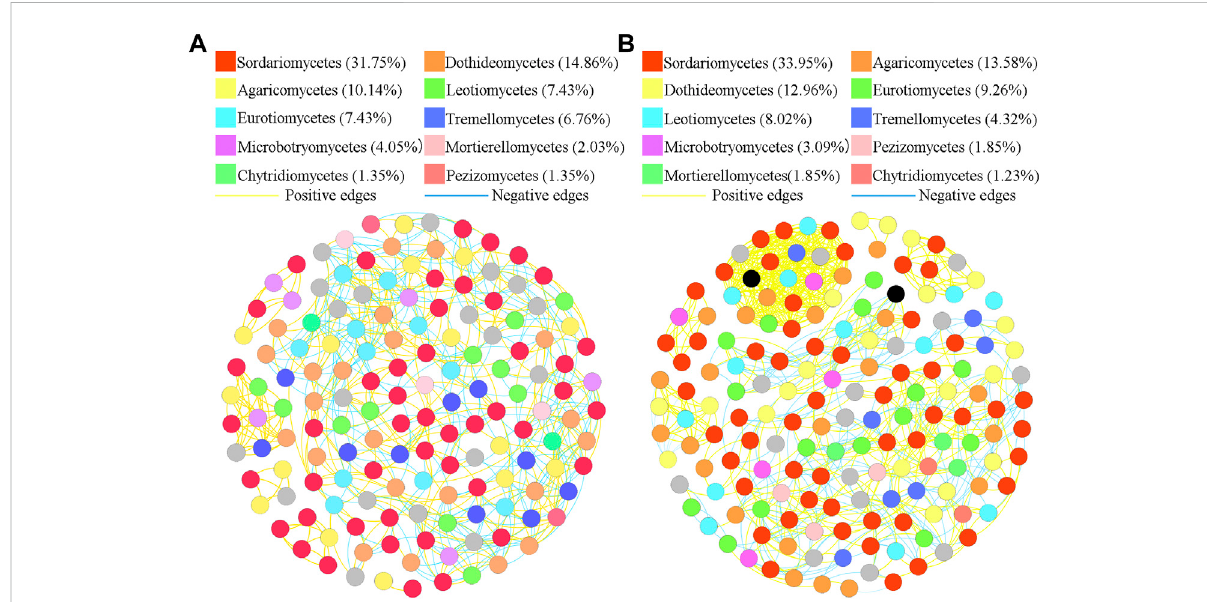
FIGURE 4 Schematic representation of symbiotic network patterns of soil fungi under different treatments at the genus level. These dots represented different genera of fungi that were clustered at class level. Different colors of the squares represent different dominant fungal genera that were clustered (only listthetop tenfungal classes).Yellowlinesbetween anyconnectedtwonodesindicatesapositive relationshipandbluelinesindicate a negative relationship (A) Schematic diagram of fungal community network in healthy bulk soils. (B) Schematic diagram of fungal community network in diseased bulk soils.